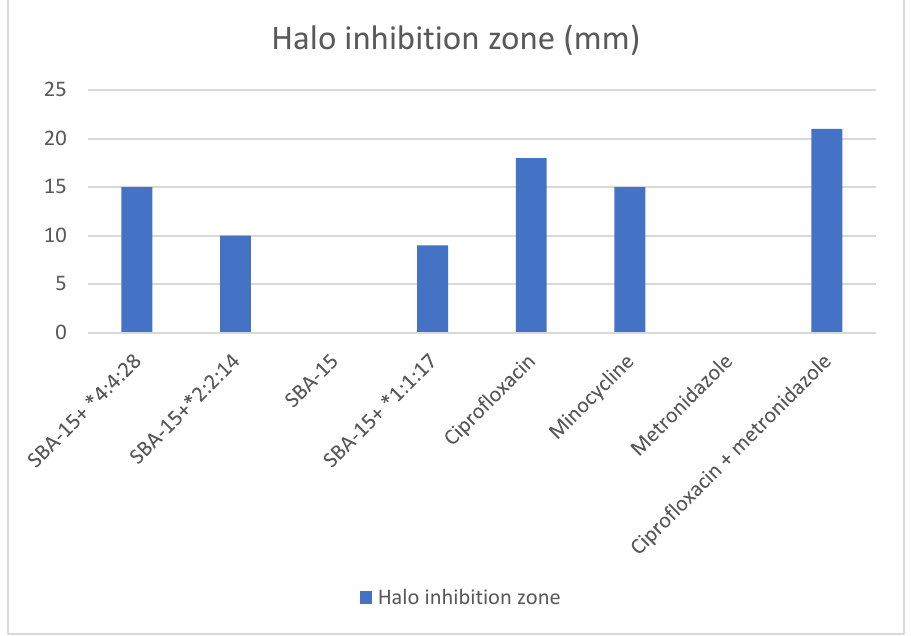
Figure 2. Antibacterial activity of the different drug solutions evaluated. * (Ci:Me:Mi). MIC results (Figure 3) revealed that E. faecalis is sensitive to the concentrations of the mixture of ciprofloxacin (2 mg/L), metronidazole (2 mg/L), minocycline (2.8 mg/L), ciprof- loxacin (1 mg/L), metronidazole (1 mg/L), and minocycline (1.4 mg/L), e.g., half of the normally used concentration. Regarding the ciprofloxacin and metronidazole mixture, E. faecalis is sensitive to the concentration of ciprofloxacin (1 mg/L) and metronidazole (1 mg/L), again, half the normally used concentration. However, this pathogen is not